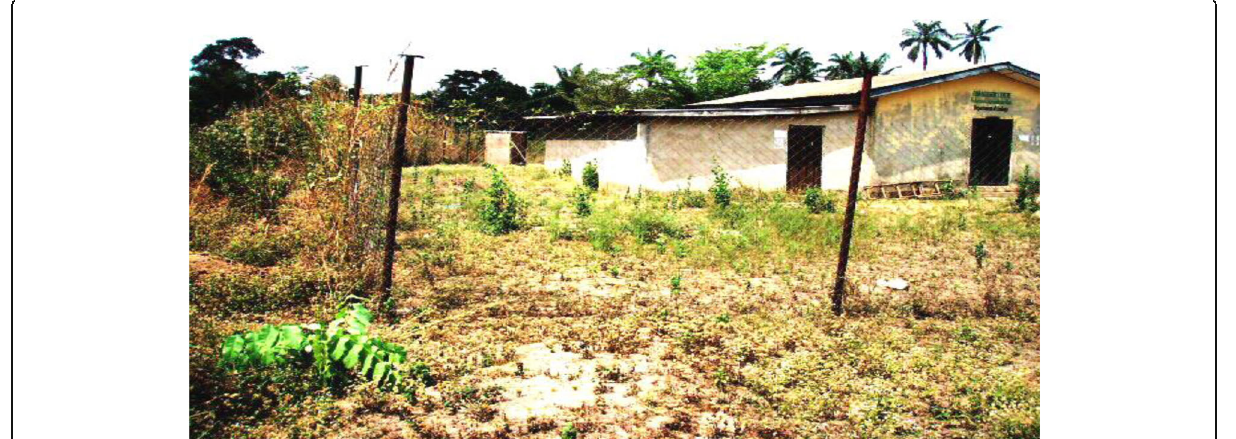
Fig. 3 Overview of the animal house, Department of Zoology Annex, where the simulated building was erected for the